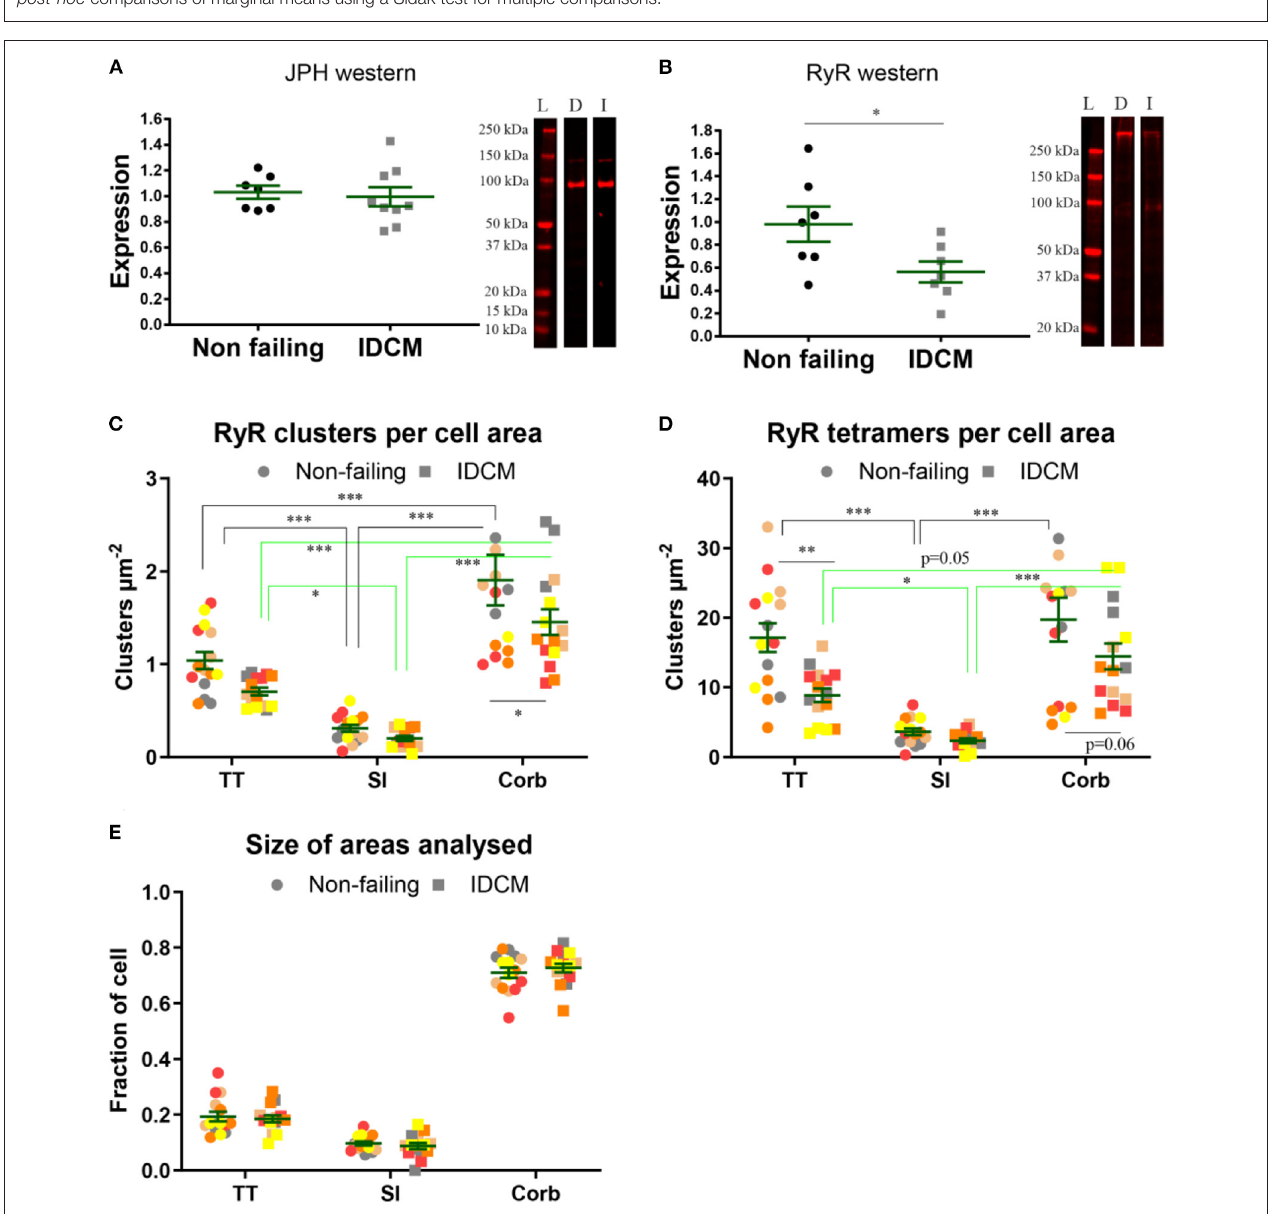
FIGURE 3 | “ (E,F) ” are from the same heart. (G) Mean number of JPH counts per RyR cluster. (H) Total number of JPH counts per RyR cluster. Groups linked with a line are significantly different in post-hoc pairwise comparison at either p < 0.05, p < 0.01, and p < 0.001 as indicated by *, **, and *** respectively. LME model was used to test for the effects of disease status (IDCM, NF) and cell region (t-tubules, sarcolemma, corbular) and random effects were in the heart. P -values reported are post-hoc comparisons of marginal means using a Sidak test for multiple comparisons.